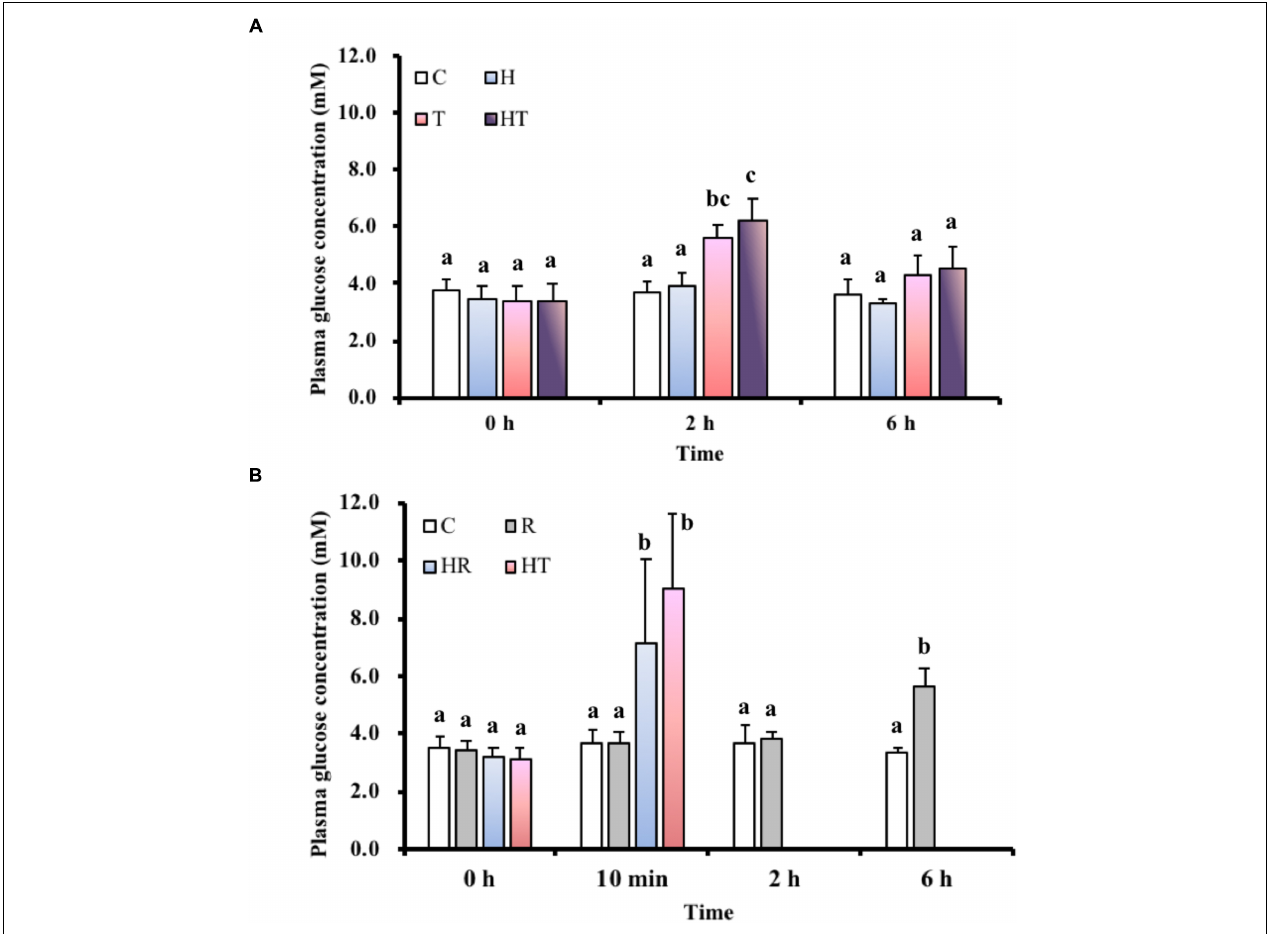
FIGURE 2 | Blood glucose levels in M. opercularis : (A) in control (C), hypoxic (H), thermal (T), and hypoxic-and-thermal (HT) ABR treatment groups at 0, 2, and 6 h ( n = 10); (B) changes in control (C), restricted (R), hypoxic (HR), and thermal (TR) ABR-restricted treatment groups at 0 h, 10 min, 2 h and 6 h ( n = 7–10). Values that were significantly different ( p < 0.05) among treatments and times are indicated by lowercase letters. Data are presented as mean ± SEM.